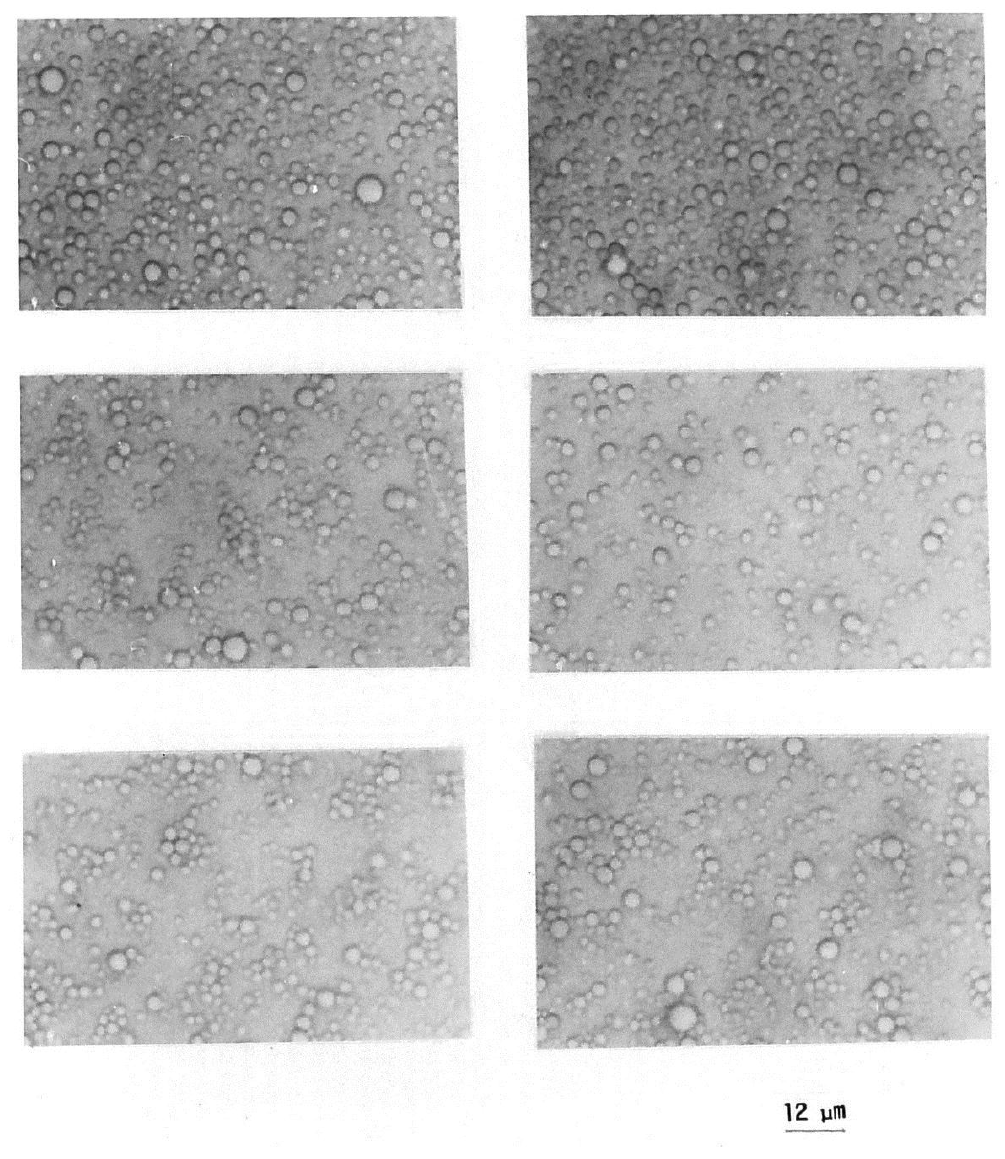
Figure 3. Typical photomicrographs of a 30.4% by volume O/W